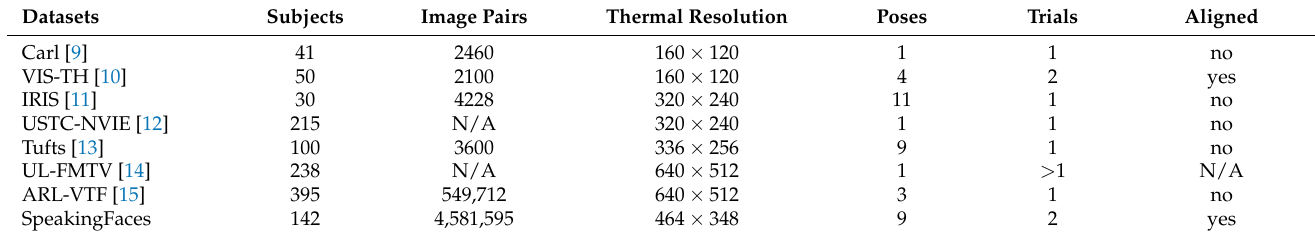
Table 1. Publicly available datasets where visual and thermal images were acquired simultaneously.